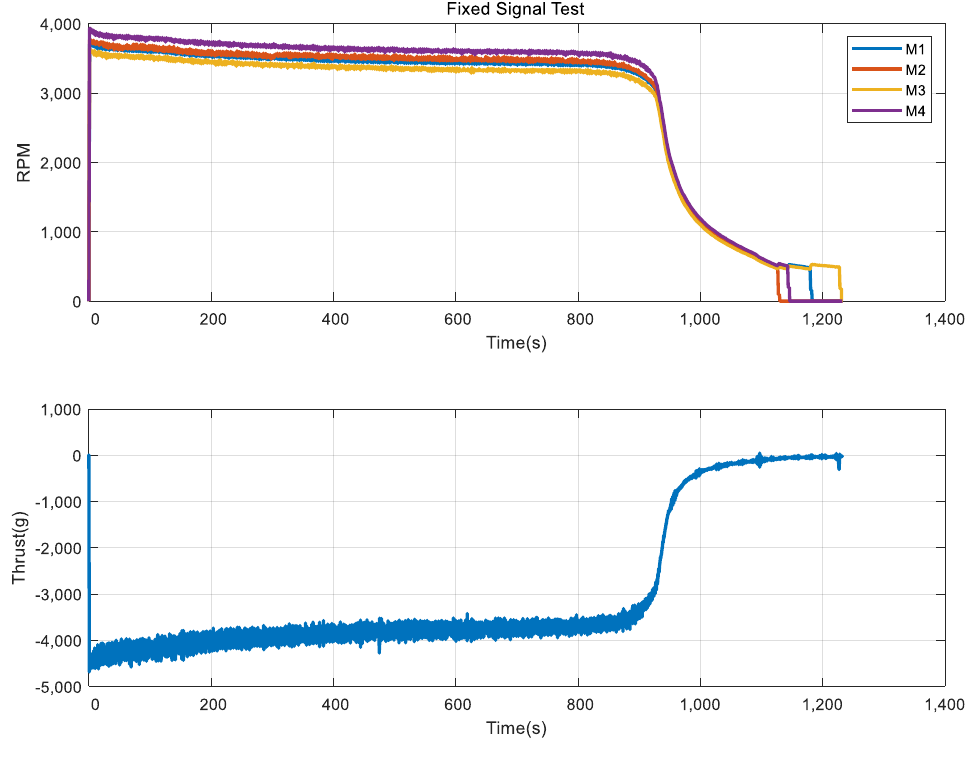
Figure 14. The results of Experiment F: maintaining control signal. Table 4. The results of the experiment maintaining the control